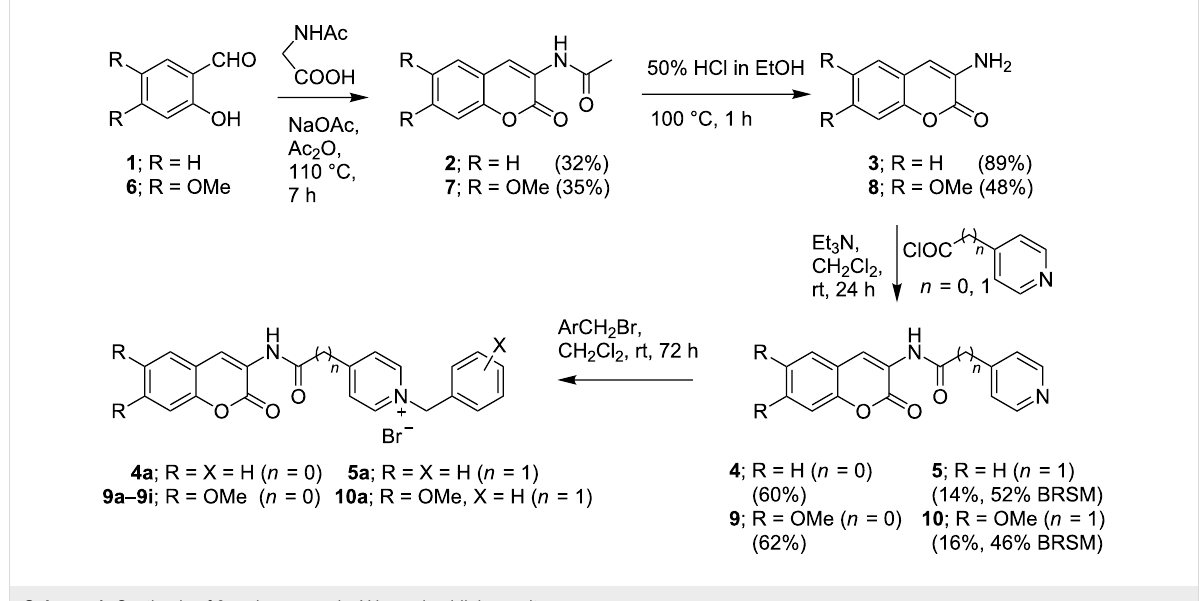
Scheme 1: Synthesis of 3-aminocoumarin- N -benzylpyridinium salts.